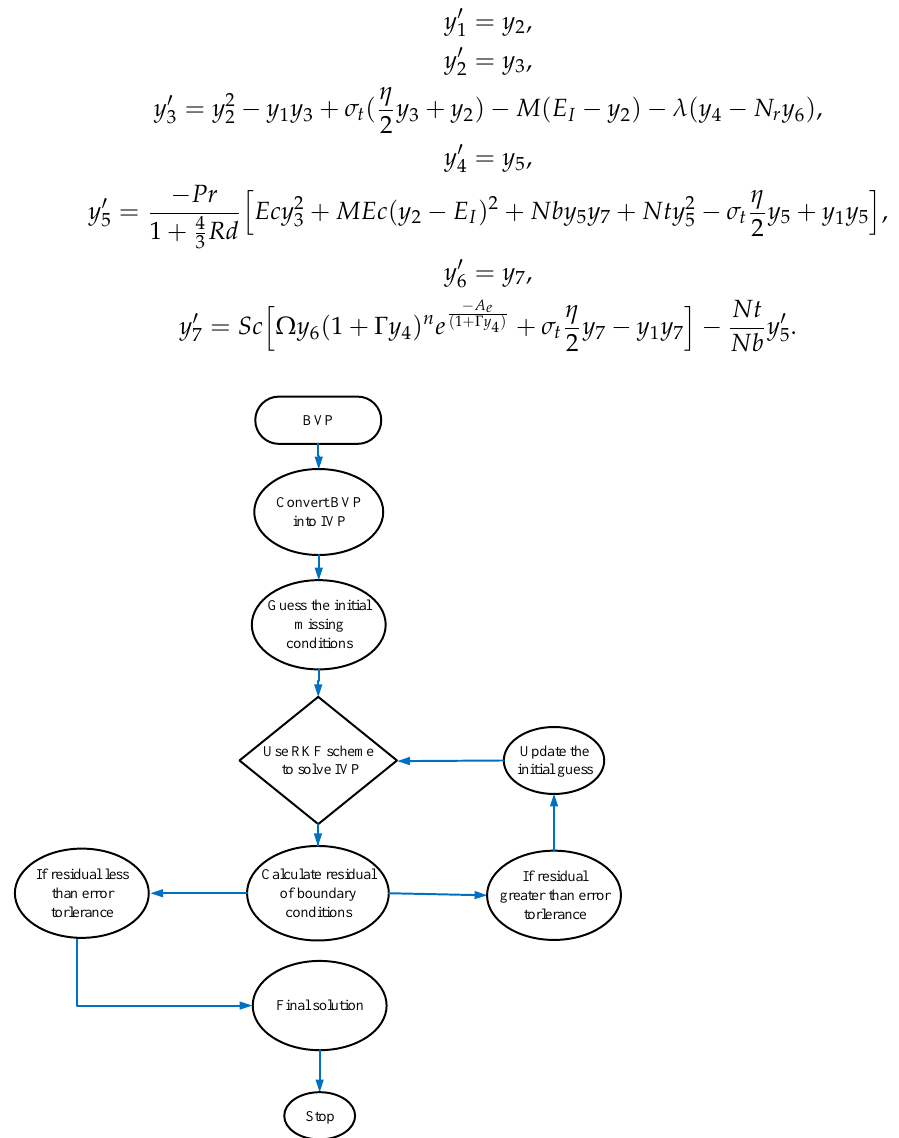
Figure 2. The algorithm of the numerical